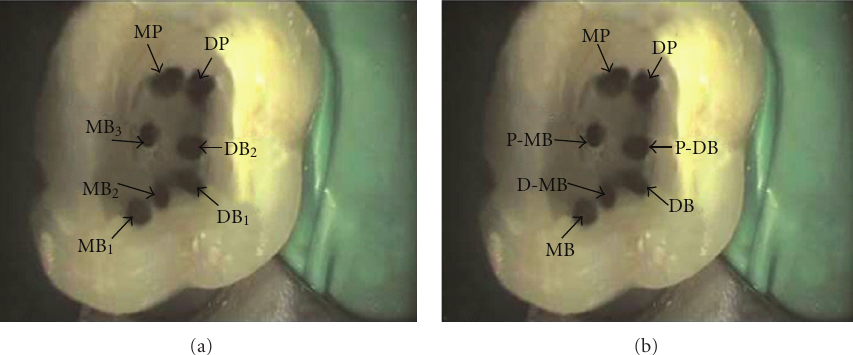
Figure 3: (a) Picture of the access cavity of the maxillary first molar showing the locations of the seven canals contained within the three principle roots and named using the traditional nomenclature. MB: mesiobuccal, DB: distobuccal, DP: distopalatal, and MP: mesiopalatal. (b) Naming of the canals in (a) as per the proposed nomenclature; P-MB: palato-mesiobuccal, D-MB: disto-mesiobuccal, P-DB: palato- distobuccal. (Reprinted with permission from Kottoor et al. [7].)